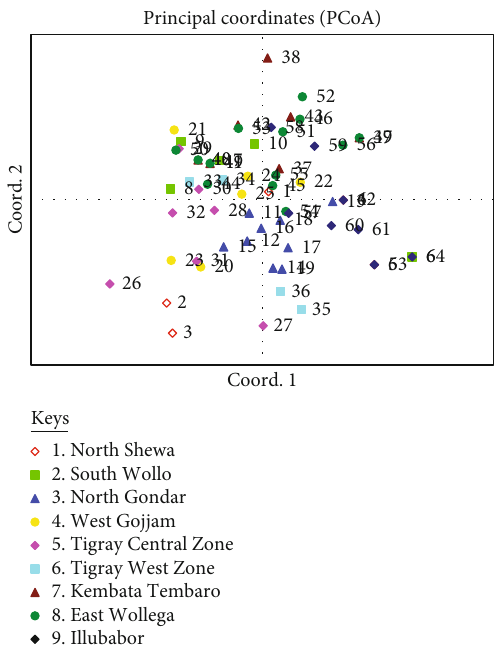
Figure 1: Principal coordinates analysis (PCoA) biplot showing the clustering pattern of 64 tef from the nine